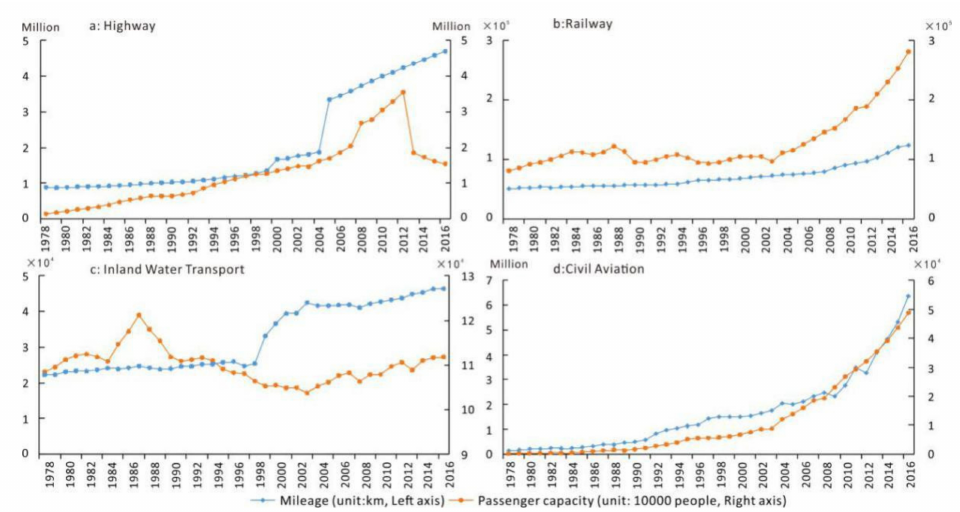
Figure 8. The mileage and passenger capacity of highways, railways, inland water transport, and civil aviation from 1978 to